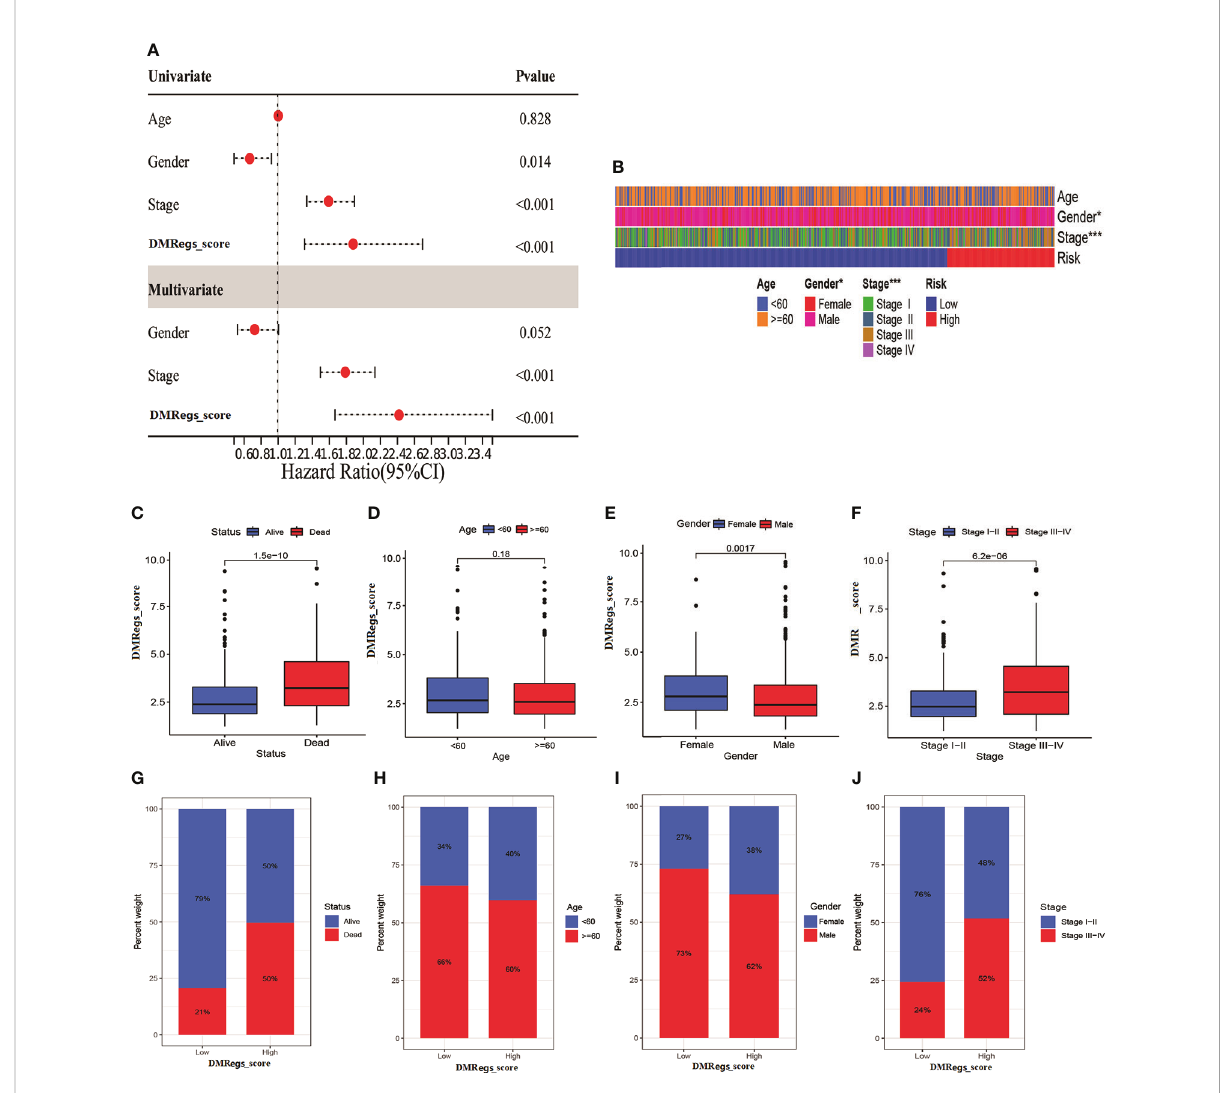
FIGURE 8 The clinical features of DMRegs_score in HCC patients. (A) The forest plot of univariate and multivariate cox analysis for independent prognostic factor. (B) The correlation heatmap of two risk groups with different clinical features. (C – F) . The correlation between DMRegs_score and survival status, age, gender and TNM stage. (G – J) The percentile of patients with different clinical features in two risk group. * P < 0.05, ** P < 0.01, *** P < 0.001, **** P <